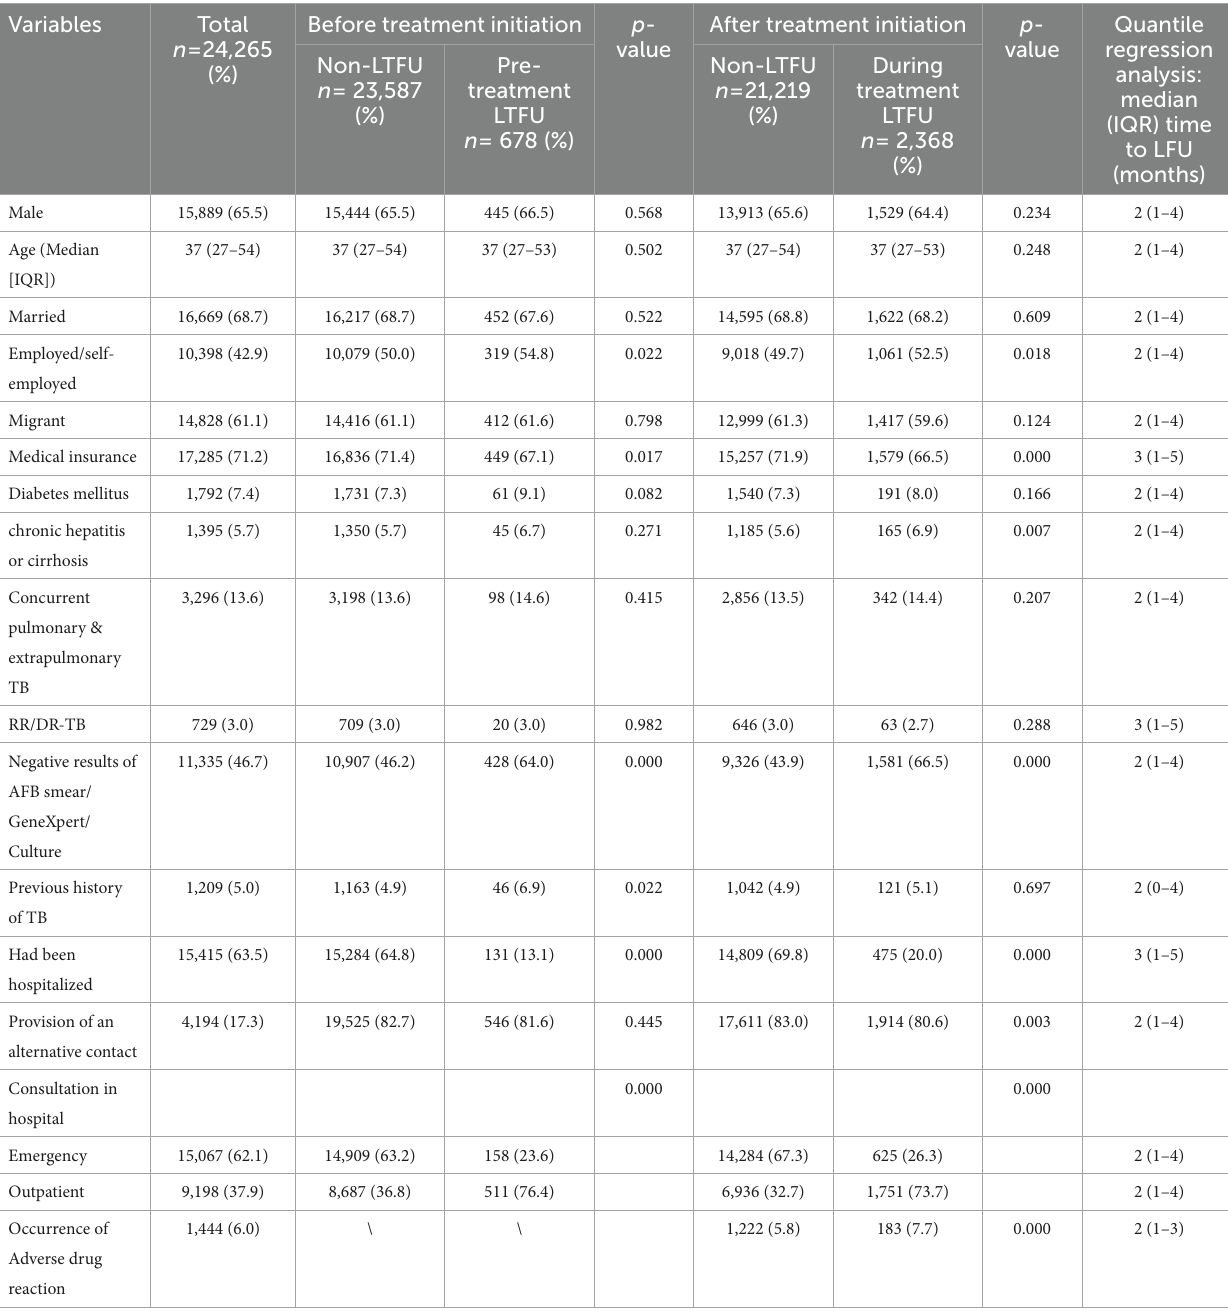
TABLE 1 Sociodemographic characteristics and clinical information of loss-to-follow-up (LTFU) rate in patients with tuberculosis (TB) vs. patients adhering to treatment from 2017 to 2021 ( n =